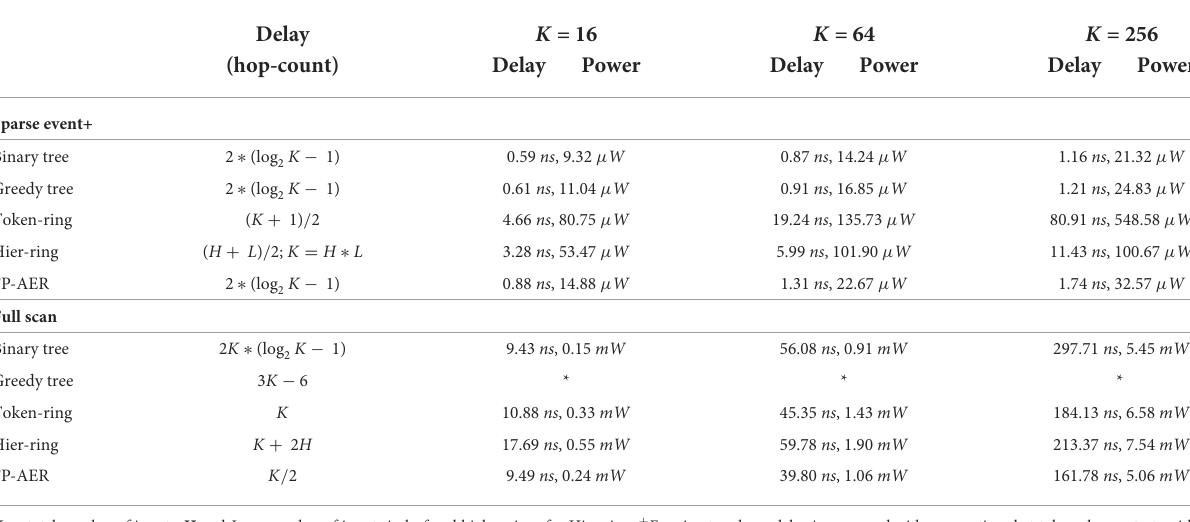
TABLE 1 Delay and power estimation for different address-event